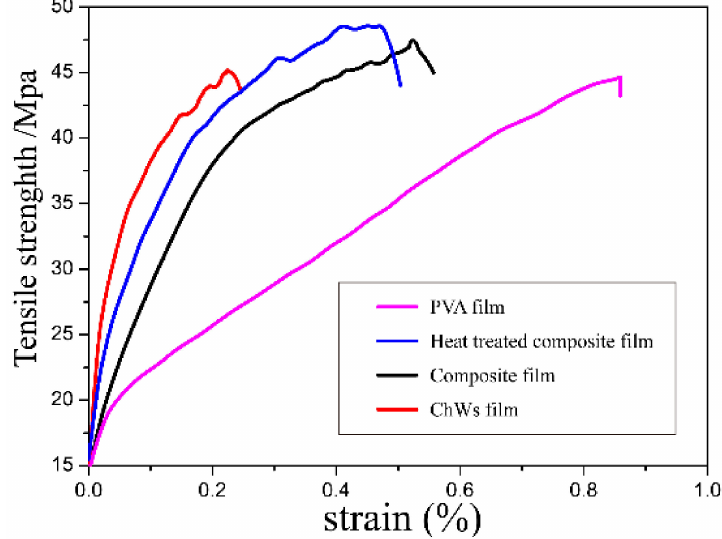
Figure 5. Tensile strength of the pure PVA film, ChWs film, PVA/ChWs composite film and heat treated PVA/ChWs composite